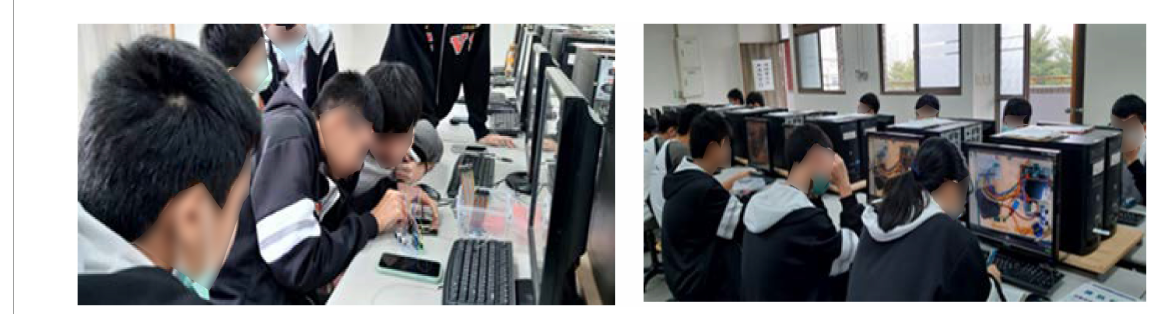
FIGURE4 The practical operations and stimulating applications of the ultrasonic sensor.